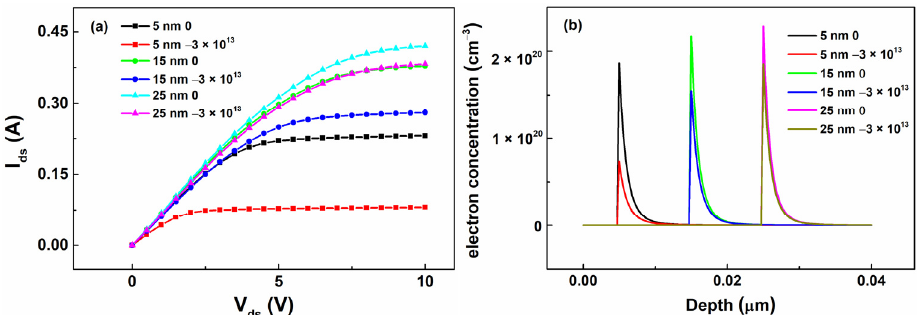
Figure 5. ( a ) The output characteristics and ( b ) carrier concentration distributions of HEMT with surface charge on the structure at different InAlN barrier layer thicknesses. surface charge on the structure at different InAlN barrier layer